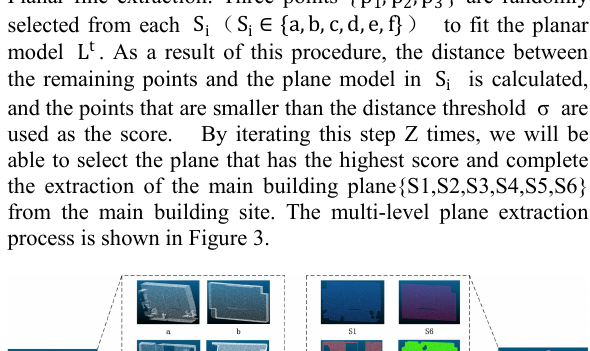
Figure 2 . Indoor component segmentation results based on deep learning.